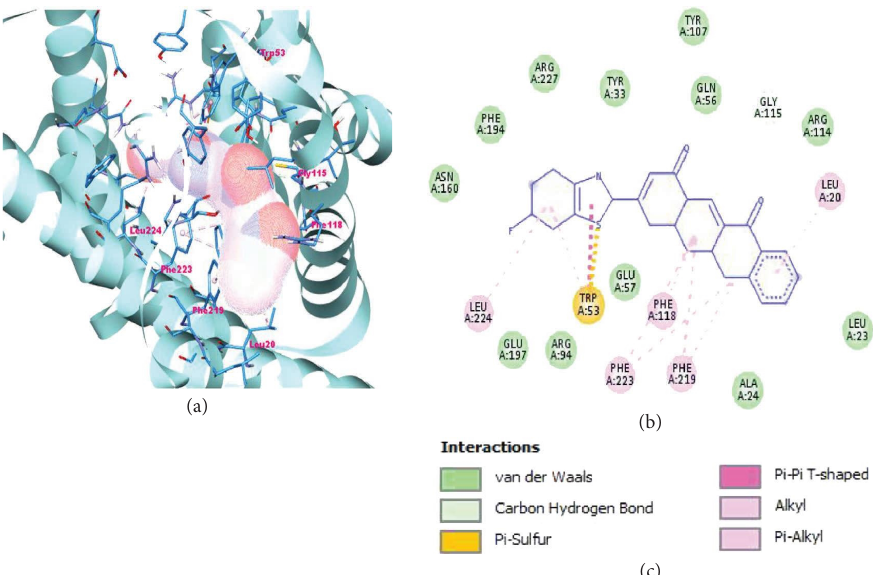
Figure 4: Te cartoon representations and 2D interactions of the 5 α R-2-hits complexes as visualized in Discovery Studio v19.1.0.18287 [36]: (a) Cartoon of 5 α R-2-A1 complex, (b) 2D interaction of 5 α R-2-A1 complex, and (c) legend of interactions. Table 3: Pharmacological and physicochemical profling of the hit compounds computed molecular weight (MW), number of heavy atoms (NHA), molar refractivity (MR), topological polar surface area (TPSA), gastrointestinal absorption (GI), blood-brain barrier (BBB), number of Ro5 violations (vRoF), bioavailability score (BS), and solubility score (SC).